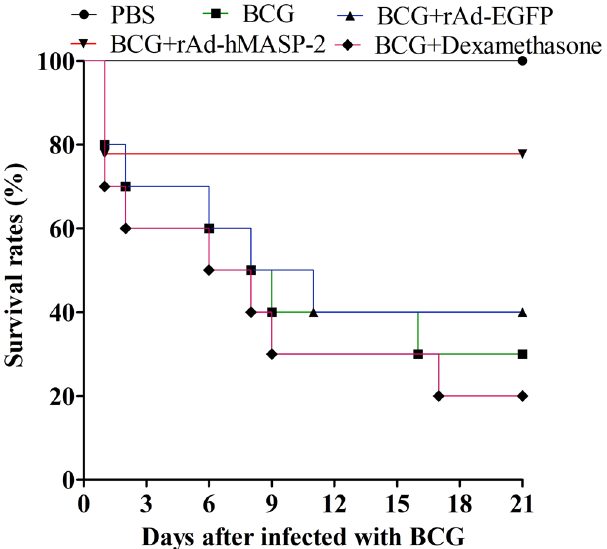
Figure 1. The 21-day survival rate of BCG-infected BALB/c mice with or without rAd-hMASP-2 treatment. BALB/c mice were intratracheally subjected to BCG and they were treated intratracheally with rAd-hMASP-2, rAd-EGFP or dexamethasone, respectively. The survival time and rate were recorded for 21 days in various groups. Statistically significant difference as compared with various groups by Pearson Chi-square test, n = 10 per group, P = 0.037. As compared with the rAd-EGFP group, rAd-hMASP-2 group showed statistically significant difference, n = 10 per group, P = 0.042. Data collected from ten mice per group were expressed as means ±